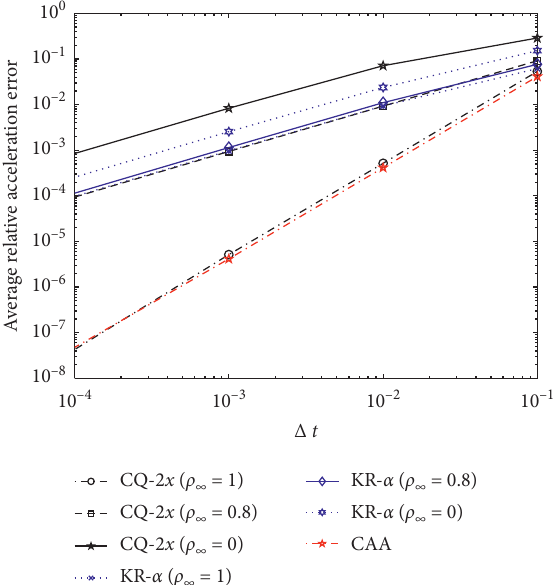
Figure 12: Convergence rate of CQ-2 x assessed in terms of the average relative acceleration